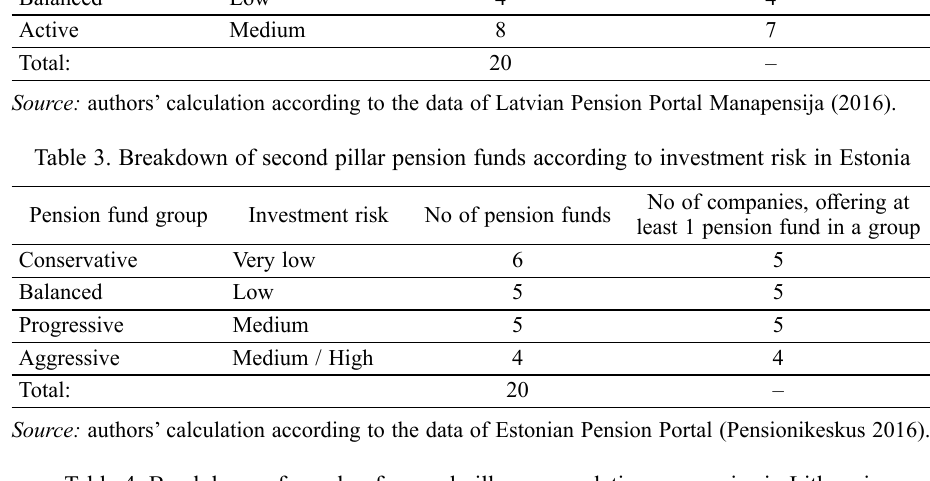
Table 4. Breakdown of supply of second pillar accumulation companies in Lithuania No of pension funds offered by pension No of pension accumulation companies accumulation company